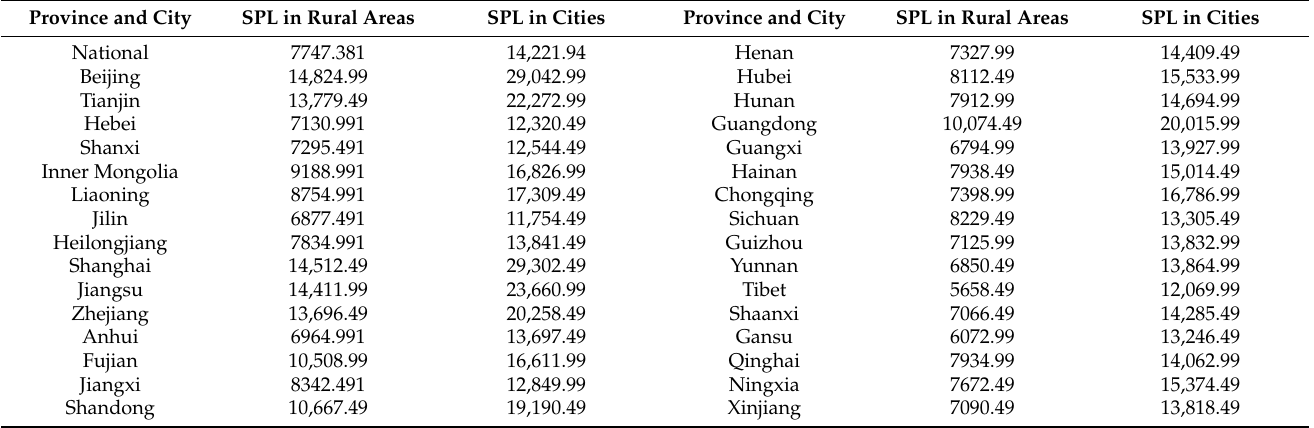
Table 3. Relative poverty lines of provinces and cities in China SPL (CNY).